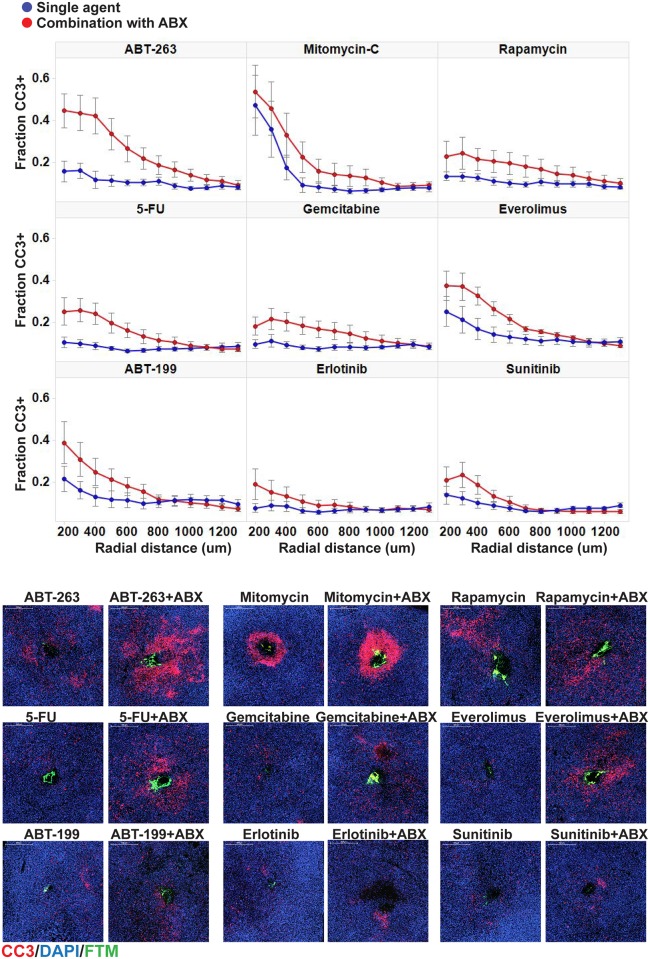
CIVO multi drug combination analysis in a xenograft model of pancreatic cancer.Using the CIVO device, MiaPaCa2 tumors were injected with single agents and combinations thereof with Abraxane® (ABX) into the same tumor (n = 4 tumors per single agent/ABX combination pair) and resected 24 hours post injection. Tissue sections were stained with cleaved caspase 3 (CC3) as a marker of apoptosis with DAPI as the counterstain. Representative radial effect curves show fraction CC3+ cells as a function of radial distance from the site of injection as demarcated by FTM. Data are averaged across four tumors. Error bars denote standard error of the mean (SEM). Representative images show cytotoxic responses at injection sites of single agents and combinations thereof with ABX.